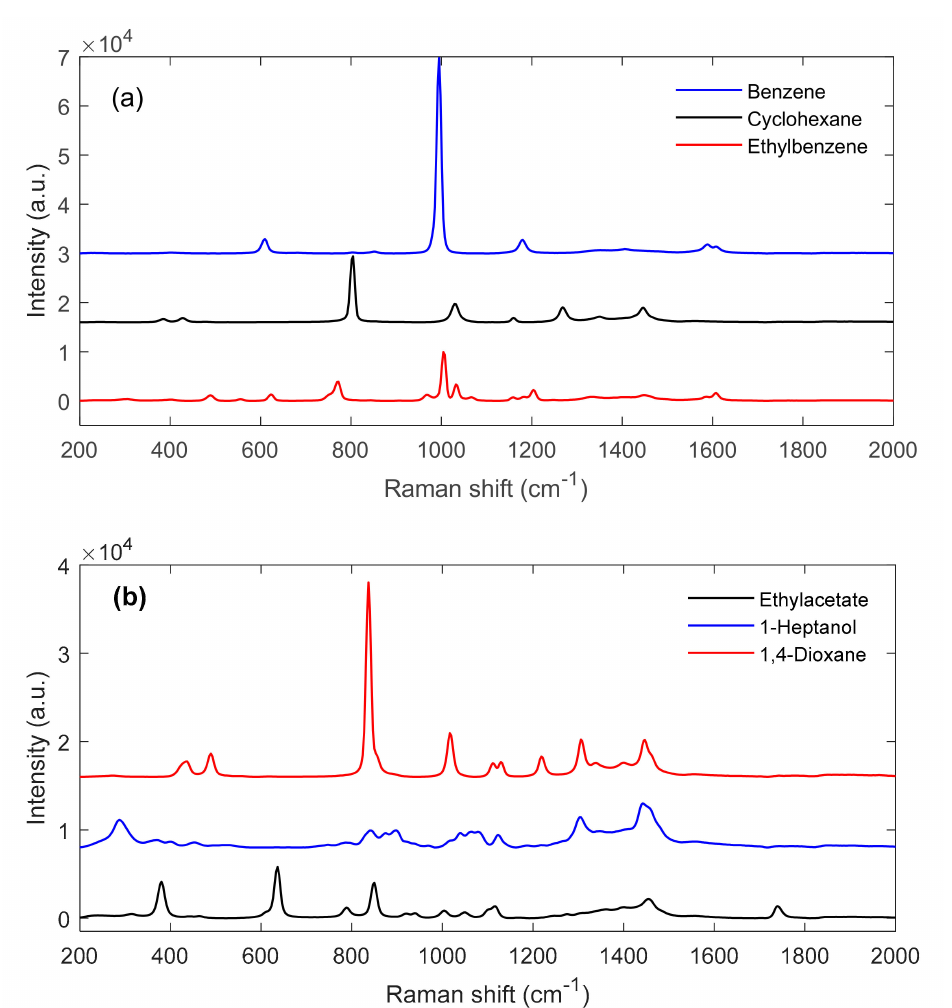
Figure 3. Raman spectra of the pure components of system 1 ( a ) and system 2 ( b